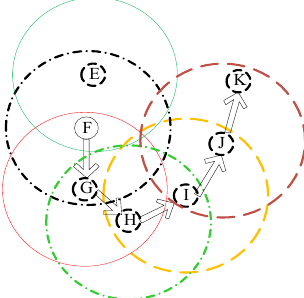
Figure 6. Backward transmission mechanism to mitigate a void-hole. Node F knows that it has no two hop neighbors in the upward direction to route packets to the sea surface. Instead, it has only Node E as a neighbor that has a depth lower than F. However, choosing E for packets’ routing will cause the packets to be stuck at E, as E has no further neighbors towards the water surface. Therefore, Node F uses Node G as a higher depth node that has two hop neighbors to further route packets to Node K via the H-I-J